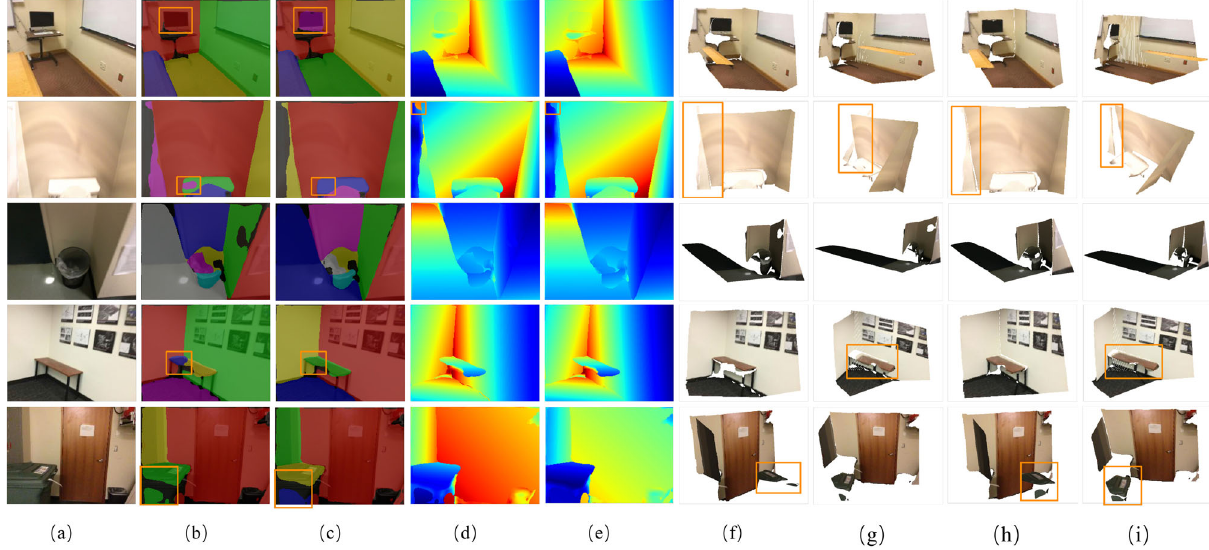
Fig. 4 Comparison between the single-view reconstruction results of our method and the baseline SVPNet [12]. (a) Input images. (b) The plane clustering results by SVPNet and (c) our method. (d) The inferred depth map by SVPNet and (e) our method. (f, g) Two novel views of the recovered models using SVPNet and (h, i) our